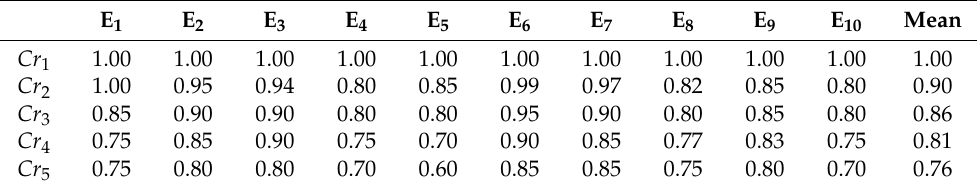
Table 7. Attitudes of respondents adapted for applying the PIPRECIA method. E